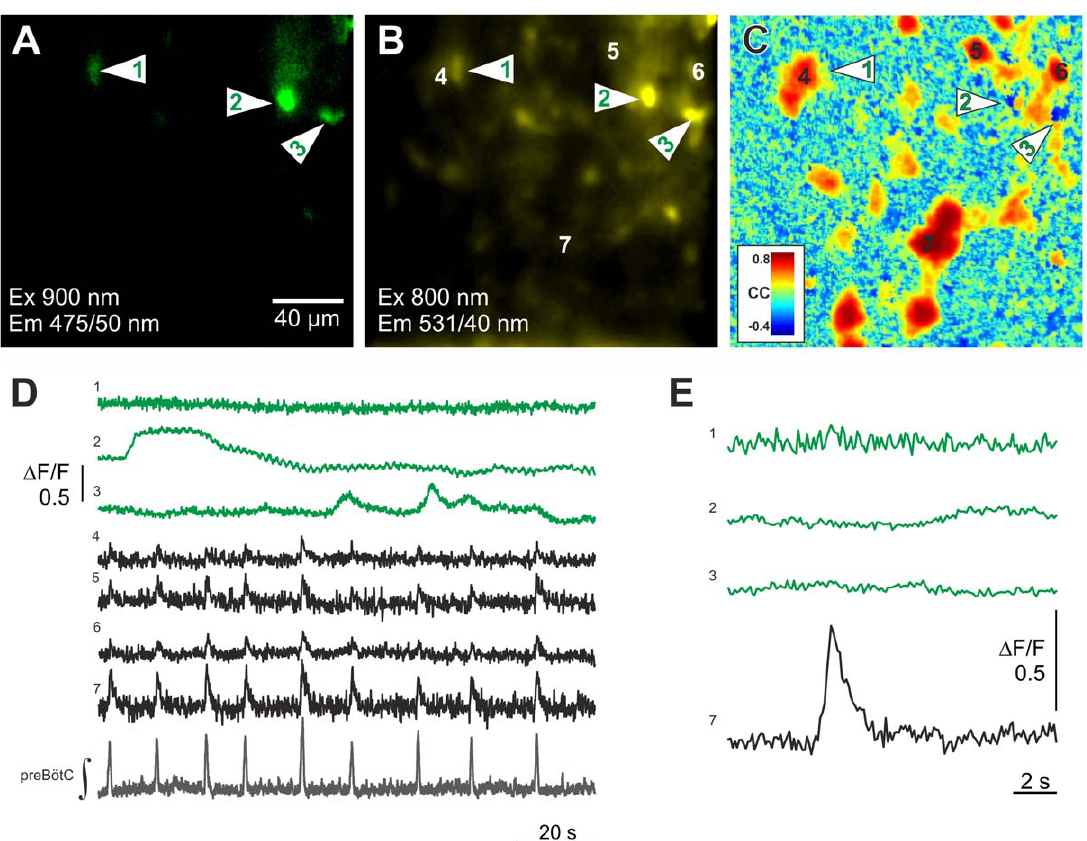
Figure 5. Lack of respiratory-rhythmic calcium signals in astrocytes of the pre-Bo¨tzinger Complex. The figure shows an example of 2- photon calcium imaging from identified astrocytes in the pre-Bo¨tzinger Complex in the presence of bicuculline (20 m M) and strychnine (10 m M). EGFP astrocytes ( A ) were labeled with Oregon Green BAPTA-1 AM (OGB-1 AM, B ). ( C ) Cross correlation (CC) maps of OGB-1 AM fluorescence were calculated for each image series between each pixel and a respiratory neuron (cell 7). In panel ( D ) the OGB-1 AM fluorescence signals from three astrocytes (1–3) and four respiratory neurons (4–7) are depicted with the integrated network output (preBo¨tC 8 ). Astrocytes show spontaneous calcium oscillations that were not phase-locked to the neuronal activity. Additionally, as shown in panel (E) the cycle-averaged data of these recording did not reveal any respiratory-rhythmic calcium signal in the astrocytes.